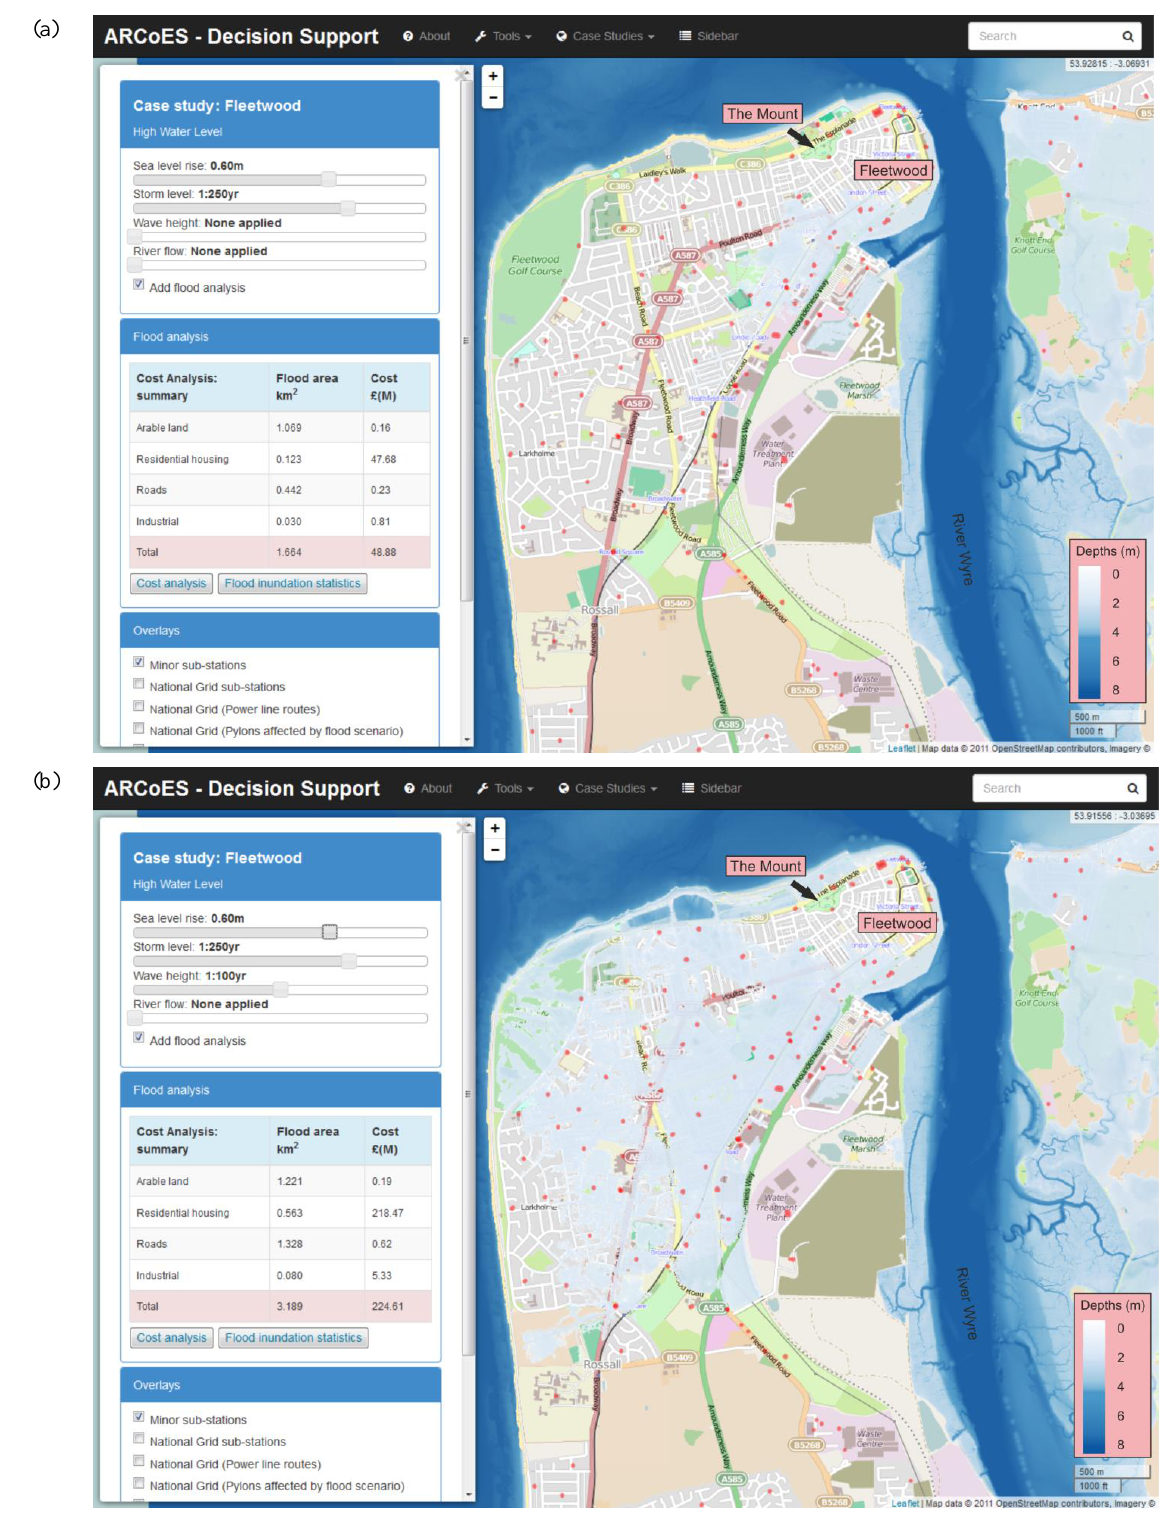
Figure 2. (a) DST screen shot of the scenario with a 0.6m sea-level rise and a 1:250 year storm level (extreme water level). Note: labels with dark-pink backgrounds have been added to screen shot. (b) DST screen shot of the scenario with a 0.6 m sea-level rise, a 1:250 year storm level (extreme water level), and a 1:100 year wave height (extreme wave height). Note: labels with dark-pink backgrounds have been added to screen